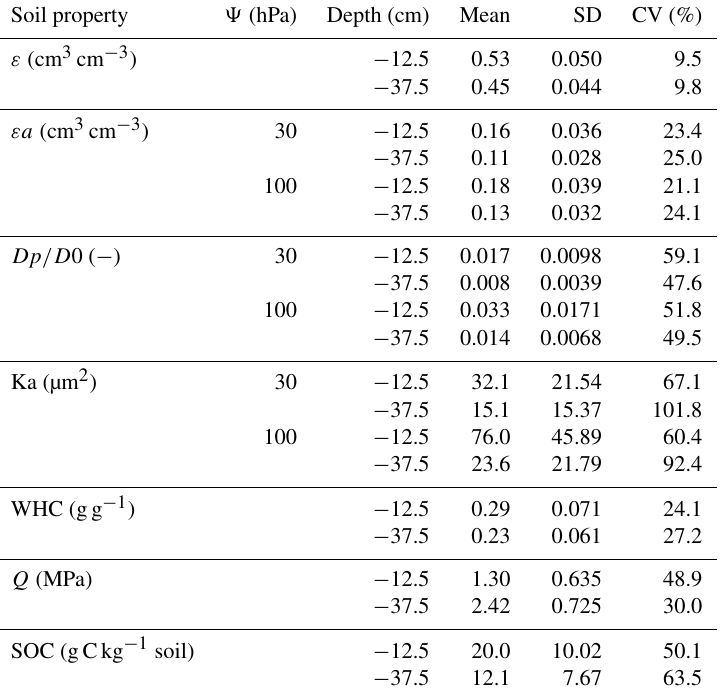
Table 2. Descriptive statistics on soil physical properties and soil organic carbon content across all three management systems. Mean, SD, and CV represent average value, standard deviation, and coefficient of variation, respectively ( n =